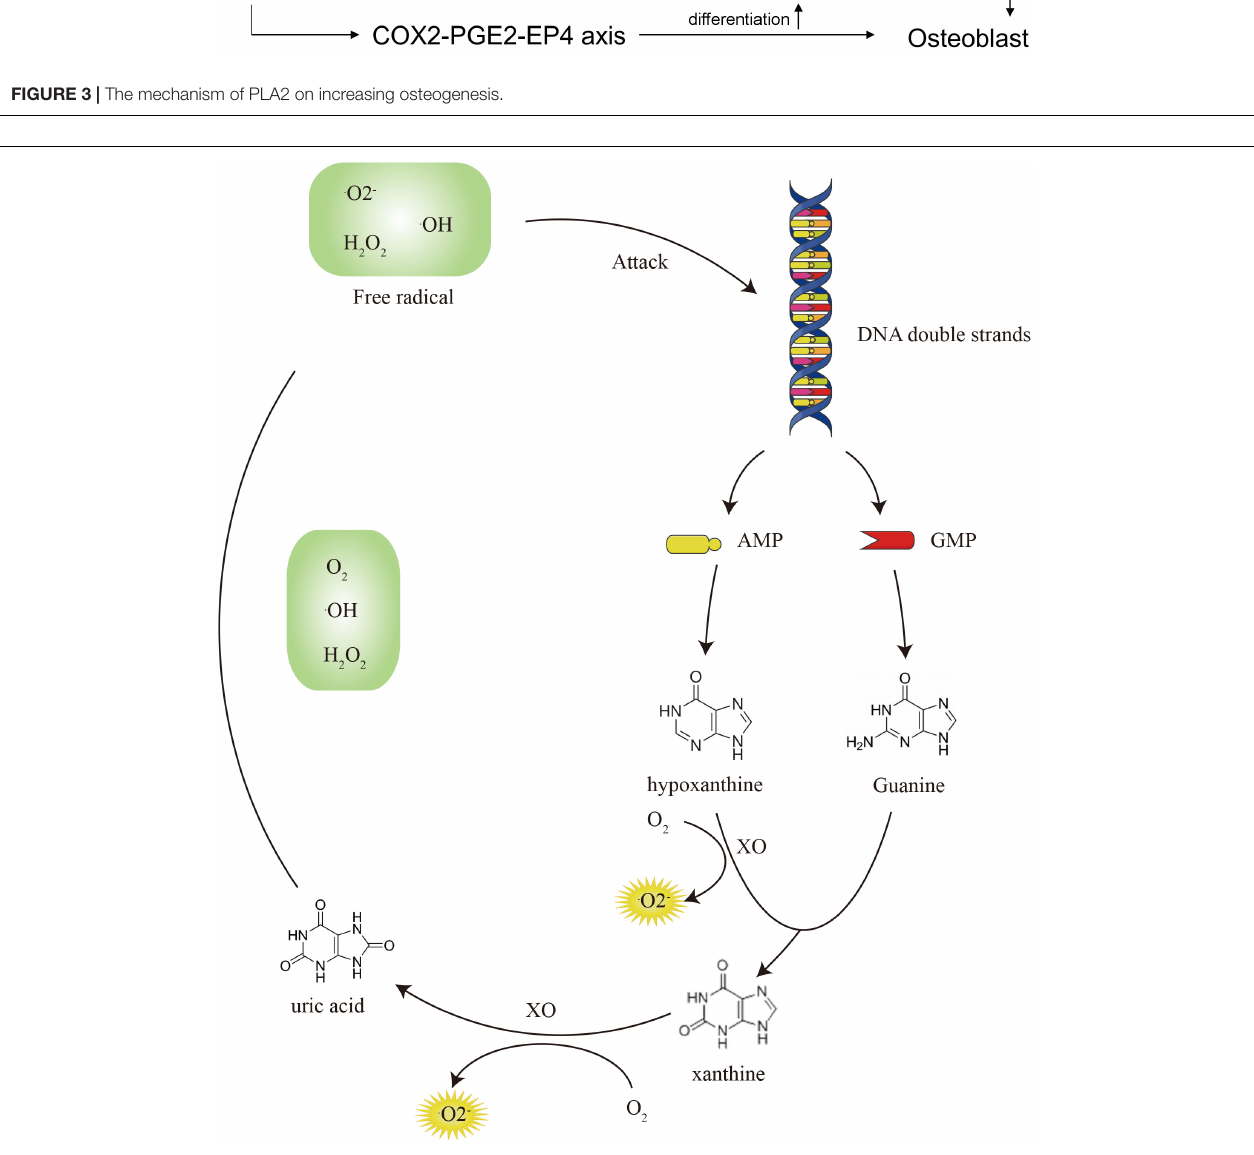
FIGURE 4 | The vicious circle of DNA damage and purine